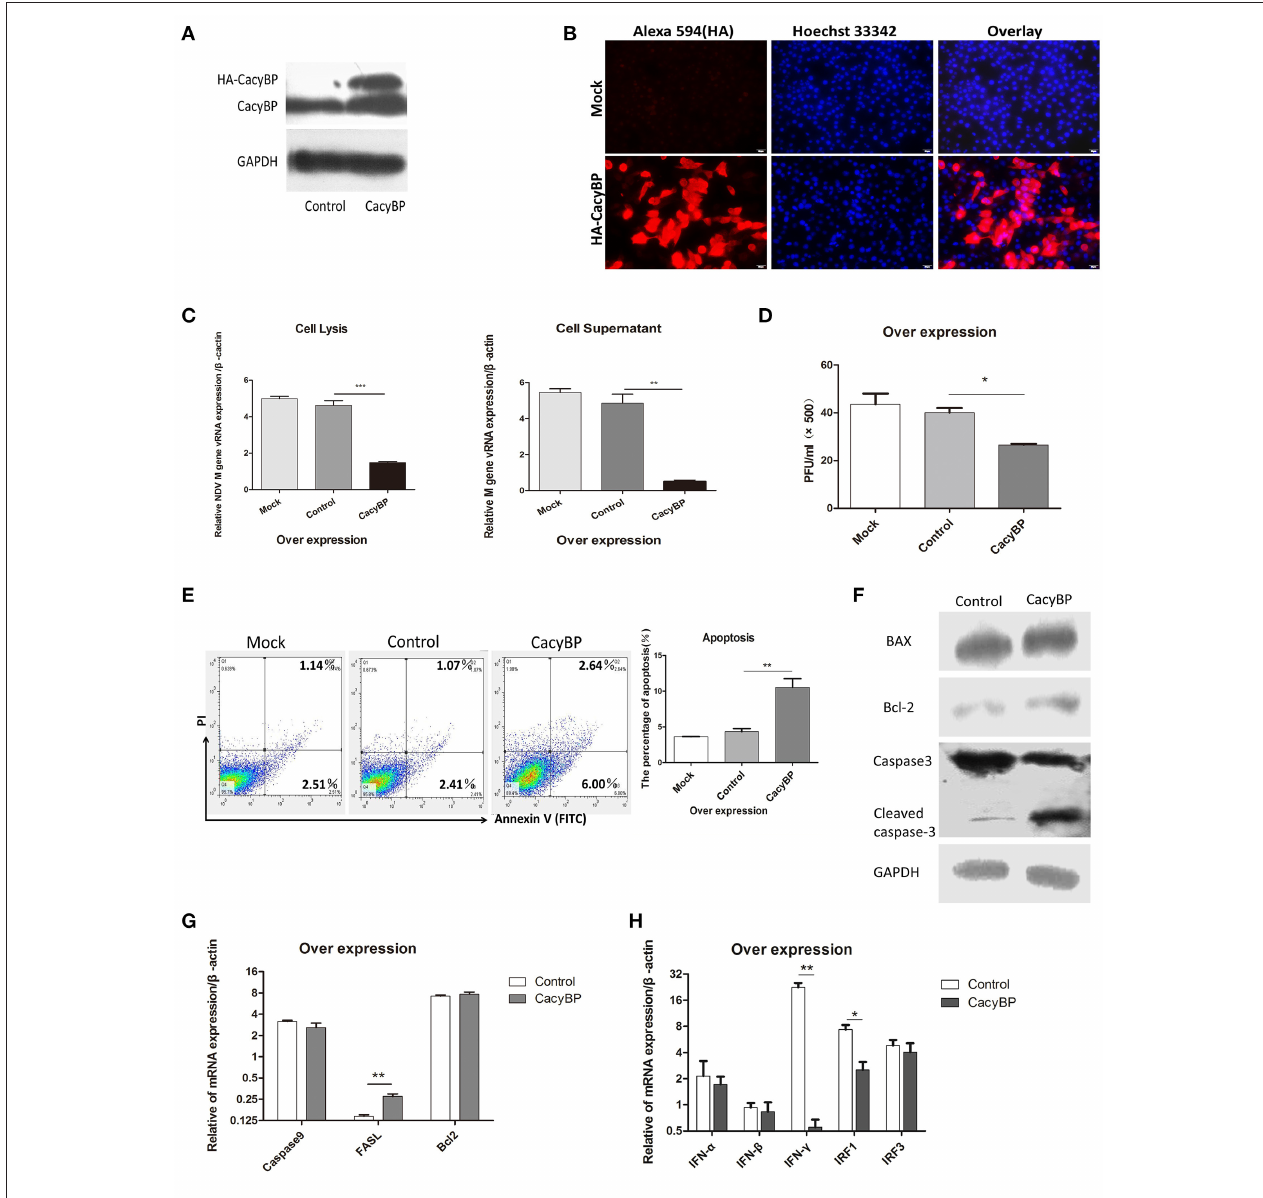
FIGURE 3 | Overexpression of CacyBP in DF-1 cells arrested viral replication and enhanced apoptosis. DF-1 cells were transfected with mock and/or control and CacyBP/SIP and incubated for 48h. Mock, treated with transfection reagent; control, transfected with pCMV-3HA; CacyBP, transfected with pCMV-3HA-CacyBP/SIP. (A) Endogenous and exogenous CacyBP/SIP was detected by western blotting. (B) Expression of the 3HA-CacyBP protein in DF-1 cells was detected using immunofluorescence. (C) Replication kinetics of NDV RNAs from DF-1 cells. Both cell lysates and supernatants were collected 48h after transfection (at 24h after transfection, 1 MOI of F48E9 NDV was inoculated in three groups). Q-PCR was used to measure viral RNA replication. (D) Viral plaque formation tests were further used to measure the number of virus particles in supernatants. (E) Flow cytometry was used to analyze cell apoptosis. DF-1 cells were transfected with mock and/or control and CacyBP/SIP and incubated for 48h, an annexin V assay was followed by flow cytometry to monitor for percentage of cells undergoing early apoptosis (bottom right quadrant) and late apoptosis(upper right quadrant).Y-axis is PI signal;X-asis is annexin V-FITC signal, right graph data were the percentage of total apoptosis (bottom and upper right quadrant)and data from three independent experiments. (F) The transfected cell lysate was analyzed by western blotting with the indicated apoptosis-related antibody. (G) Q-PCR was used to analyze the expression of apoptosis-related markers and (H) immune-associated markers 24h after transfection with pCMV-HA or pCMV-HA-CacyBP. Data shown in (C,D) are mean ± SD of four independent experiments in (E,G,H) are mean ± SD of three independent expriments. * P < 0.05; ** P < 0.01; *** P < 0.001.